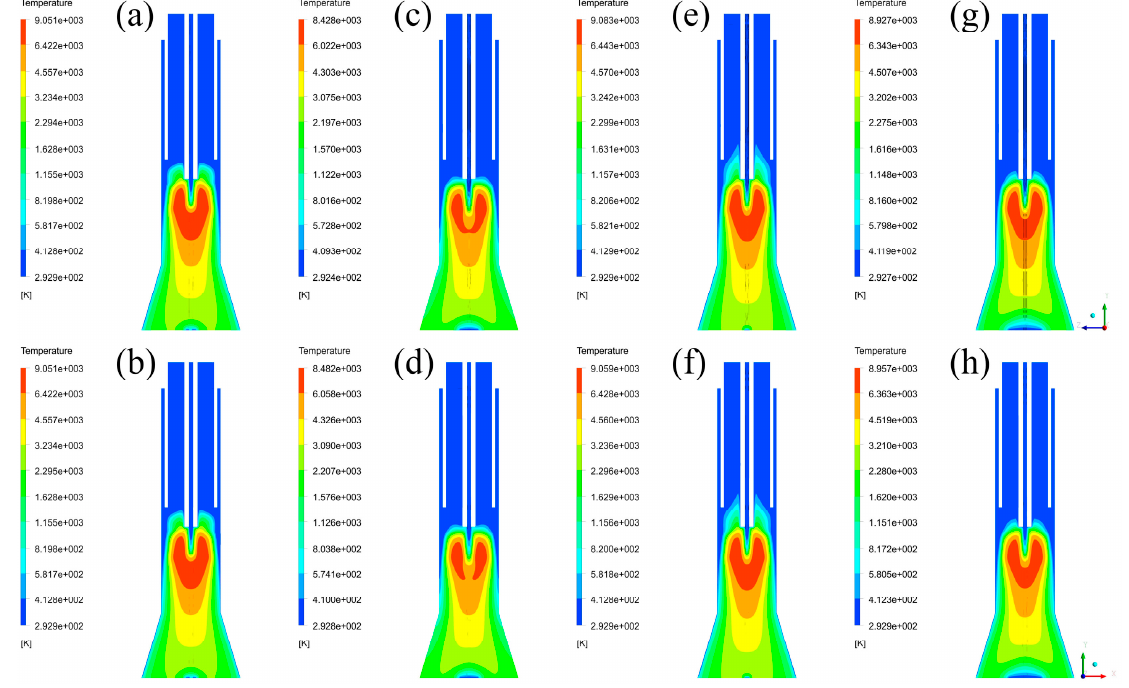
Figure 3. Temperature fields: ( a ) Case A in YZ plane, ( b ) Case A in XZ plane, ( c ) Case B in YZ plane, ( d ) Case B in XZ plane, ( e ) Case C in YZ plane, ( f ) Case C in XZ plane, ( g ) Case D in YZ plane, ( h ) Case D in XZ plane.